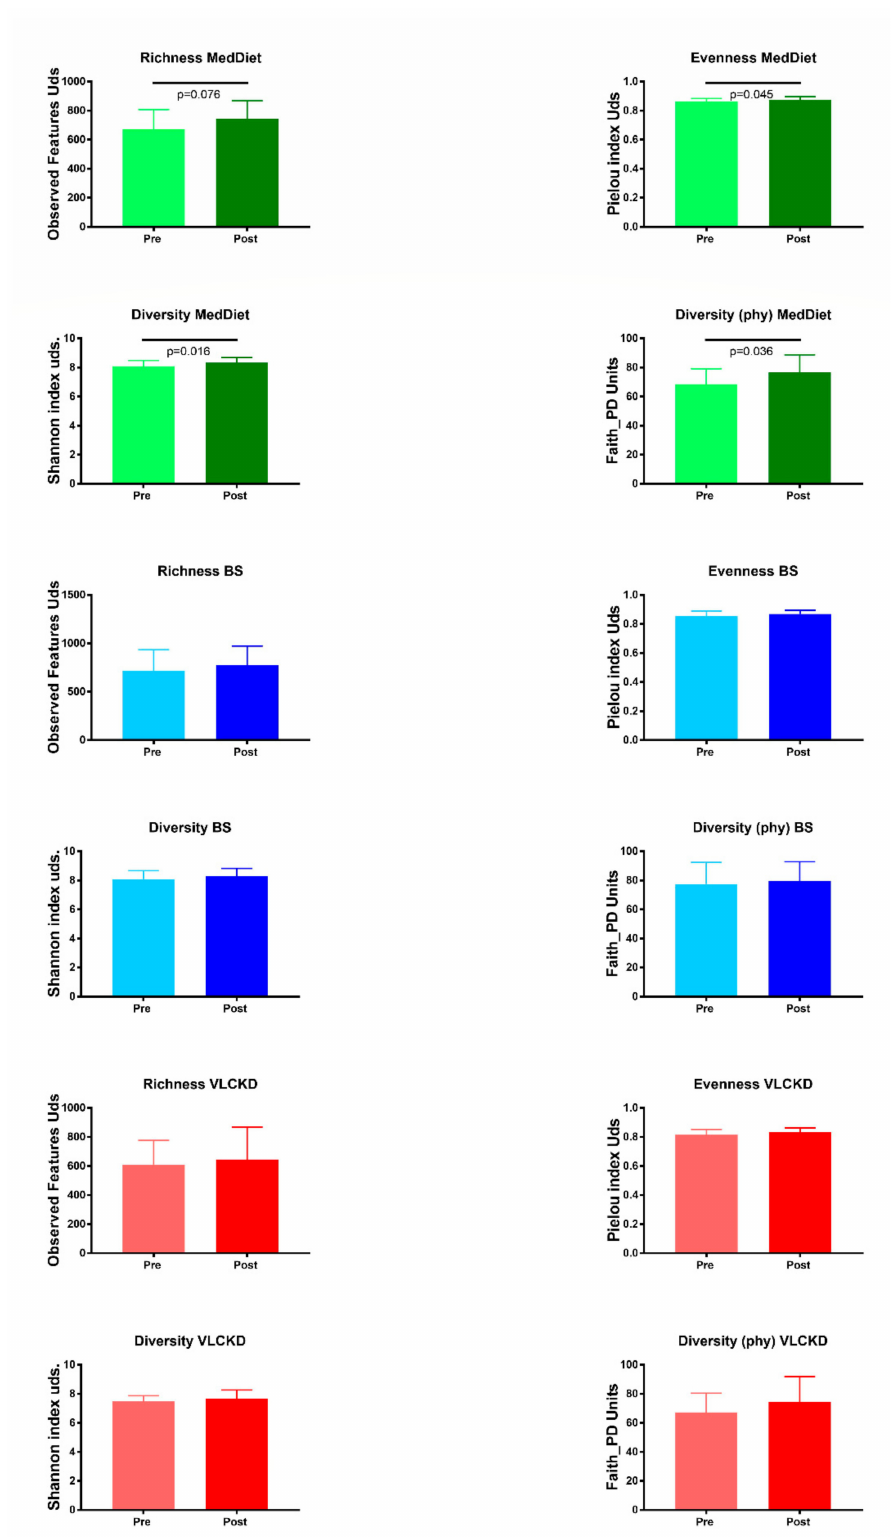
Figure 1. α -diversity indexes at baseline and the end of the study in the three interventions. MedDiet: Mediterranean Diet group ( n = 21). BS: Bariatric surgery group ( n = 22). VLCKD: very-low calorie ketogenic diet group ( n = 18). Pre: at baseline. Post: at the end of the